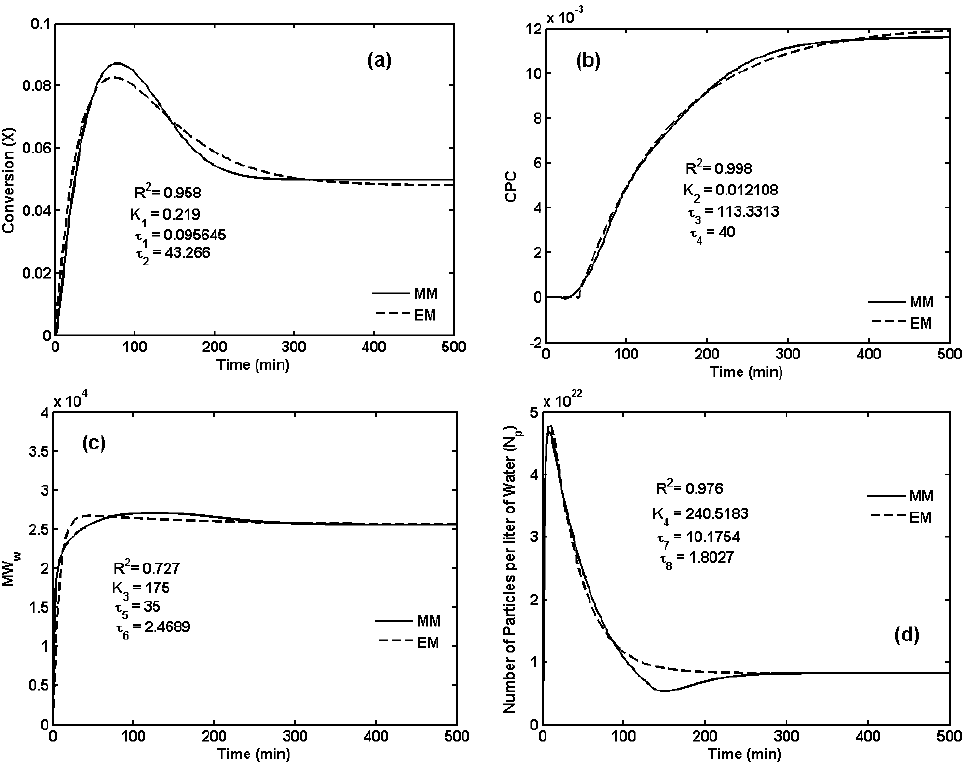
Figure 6. Comparison of the responses obtained from the proposed empirical models (EM) and mechanistic model (MM) for ( a ) conversion, ( b ) CPC, ( c ) MW w , and ( d ) N p .